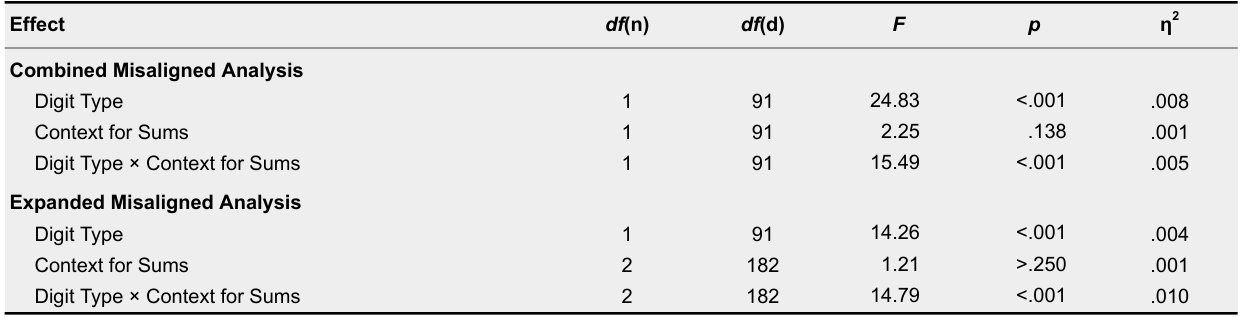
Repeated Measures Analysis of Variance on Inverse Reaction Times (trials/s) for the Number Matching